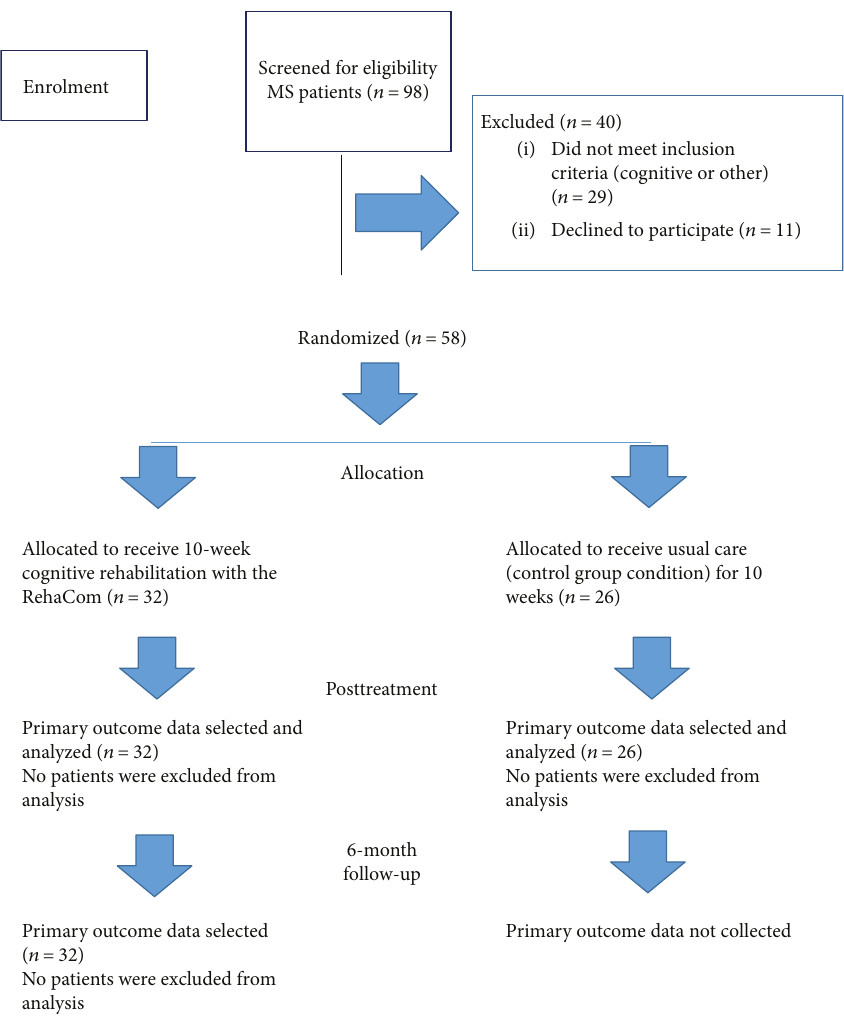
Figure 1: Consort fl ow